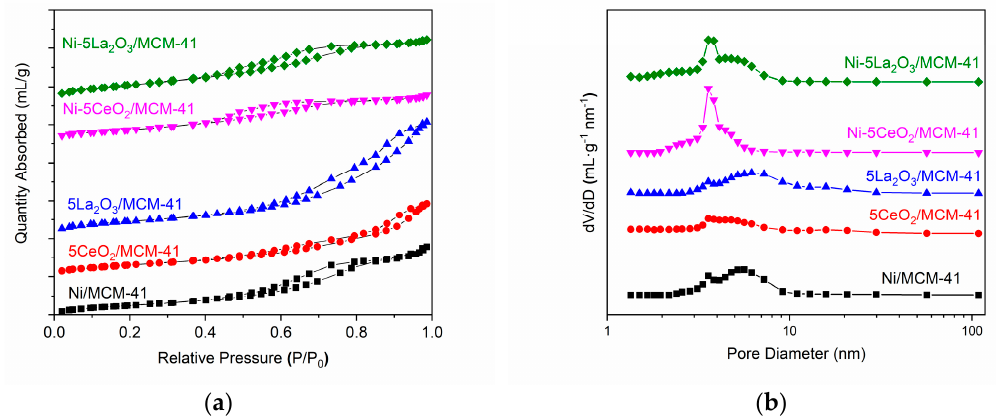
Figure 2. Transmission electron microscopy (TEM) images and energy0dispersive X ‐ ray spectroscopy (EDS) elementary mapping images of Ni/MCM ‐ 41 (a), Ni ‐ 5La 2 O 3 /MCM ‐ 41 (b), and Ni ‐ 5CeO 2 /MCM ‐ 41 (c).